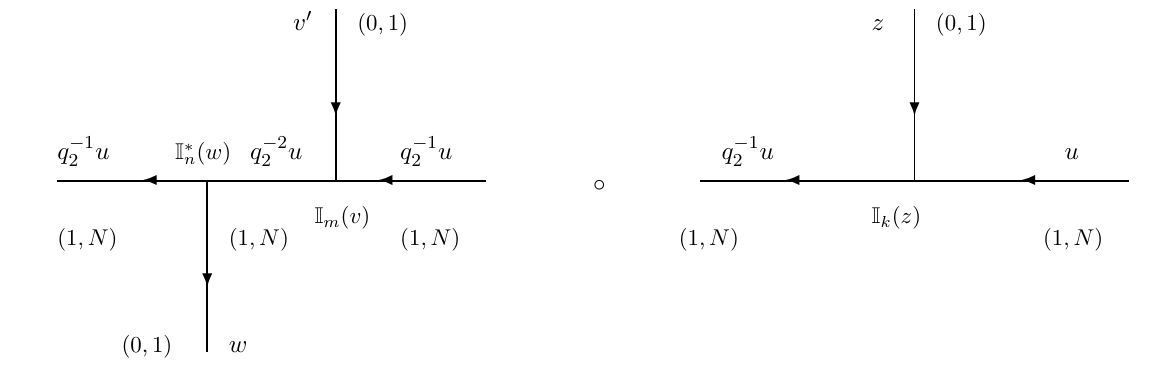
Figure 4 . Composition ◦ of the vector intertwiner and the shift operator.